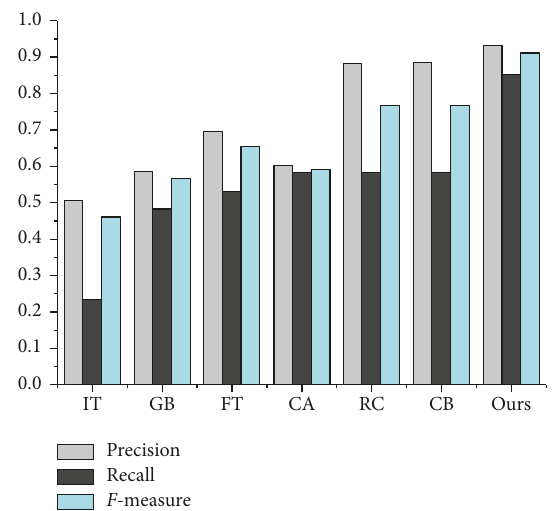
Figure 7: Comparison of different saliency detection